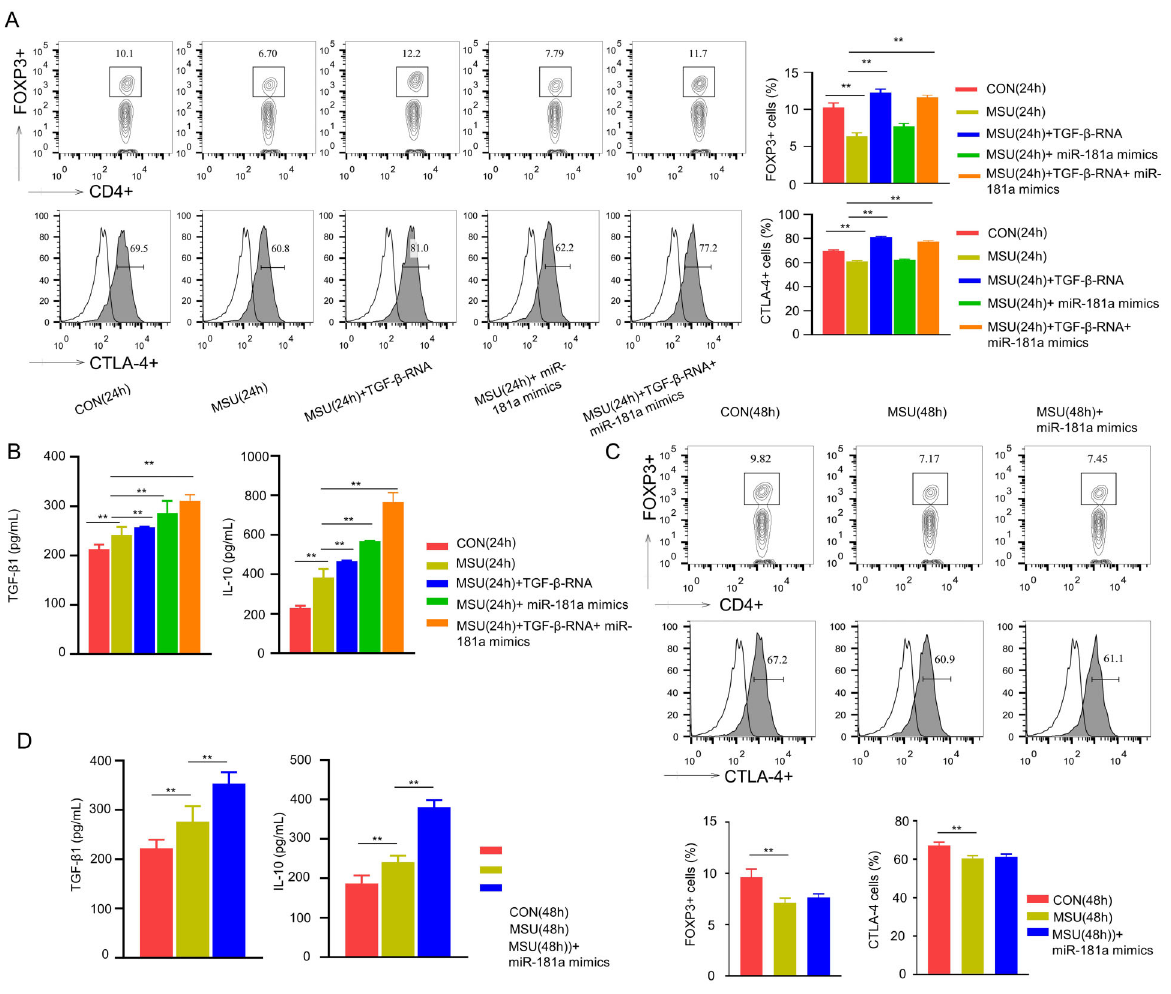
Figure 3. Overexpression of miR-181a enhances Treg responses via TGF- b 1. A , CTLA-4 and Foxp3 expression levels were determined in cells from control (CON) mice and monosodium urate (MSU)-induced mice at 24 h, in the presence or absence of TGF- b and miR- 181a overexpression. B , Upon MSU stimulation, increased IL-10 and TGF- b level was detected in Tregs isolated from MSU-induced mice at 24 h, and their expression level was further increased upon TGF- b and miR-181a overexpression. C , CTLA-4 and Foxp3 expression levels were determined in cells from both groups at 48 h, in the presence or absence of miR-181a overexpression. D , TGF- b and IL-10 were determined in Tregs isolated from both groups at 48 h, in the presence or absence of miR-181a overexpression. Data are from three independent experiments. Data are reported as means ± SD. **P o 0.01